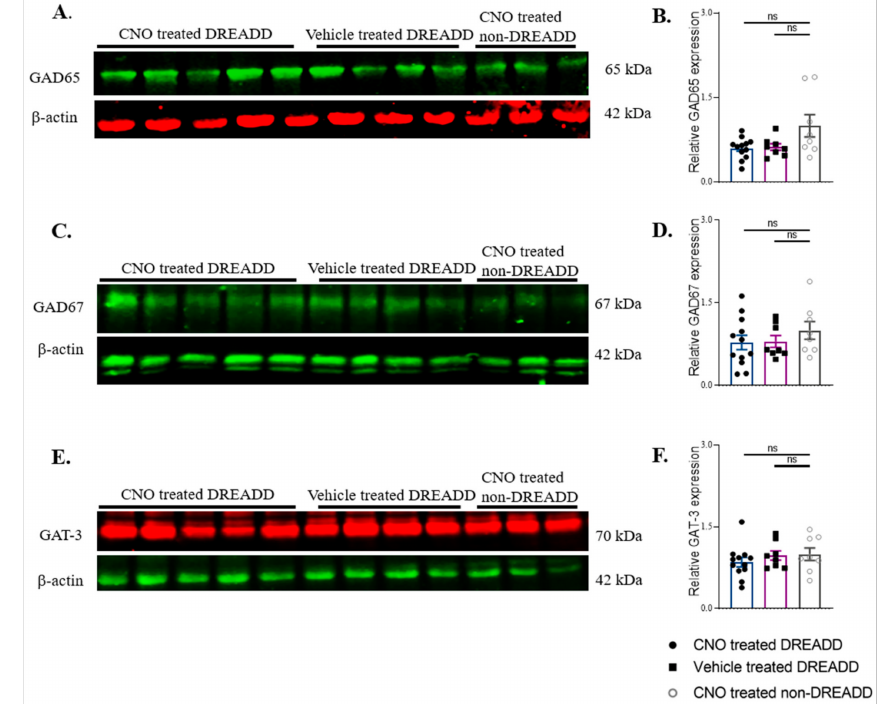
Figure 8. Western blot analysis of GAD65, GAD67, and GAT-3 in the CNO-treated DREADD animals, their vehicle-treated DREADD and CNO-treated non-DREADD control counterparts. ( A , C , E ) Representative immunoblots showing expression of GAD65, GAD67, and GAT-3 with β -actin. ( B , D , F ) Relative expression of GAD65, GAD67, and GAT-3 in the SScortex presented as bar graphs. All values represent mean ± SEM. Comparisons were performed using a Mann–Whitney unpaired rank test. ns =